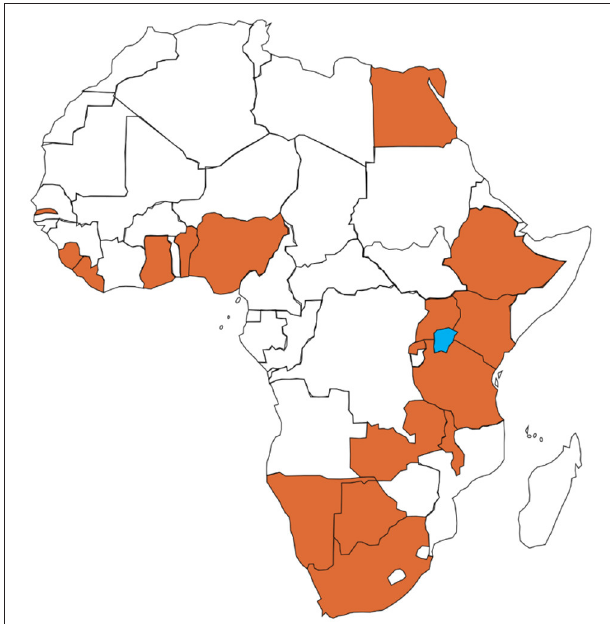
TABLE 1 | Demographic characteristics of